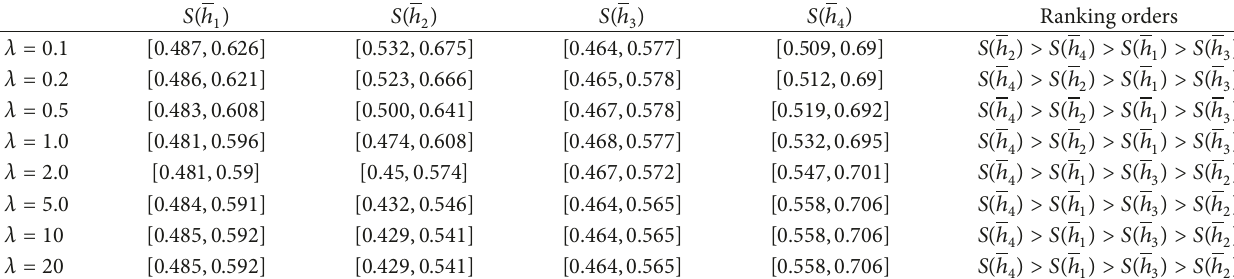
Table 10: Ranking orders based on the G-IVHF2SCHWA operator.